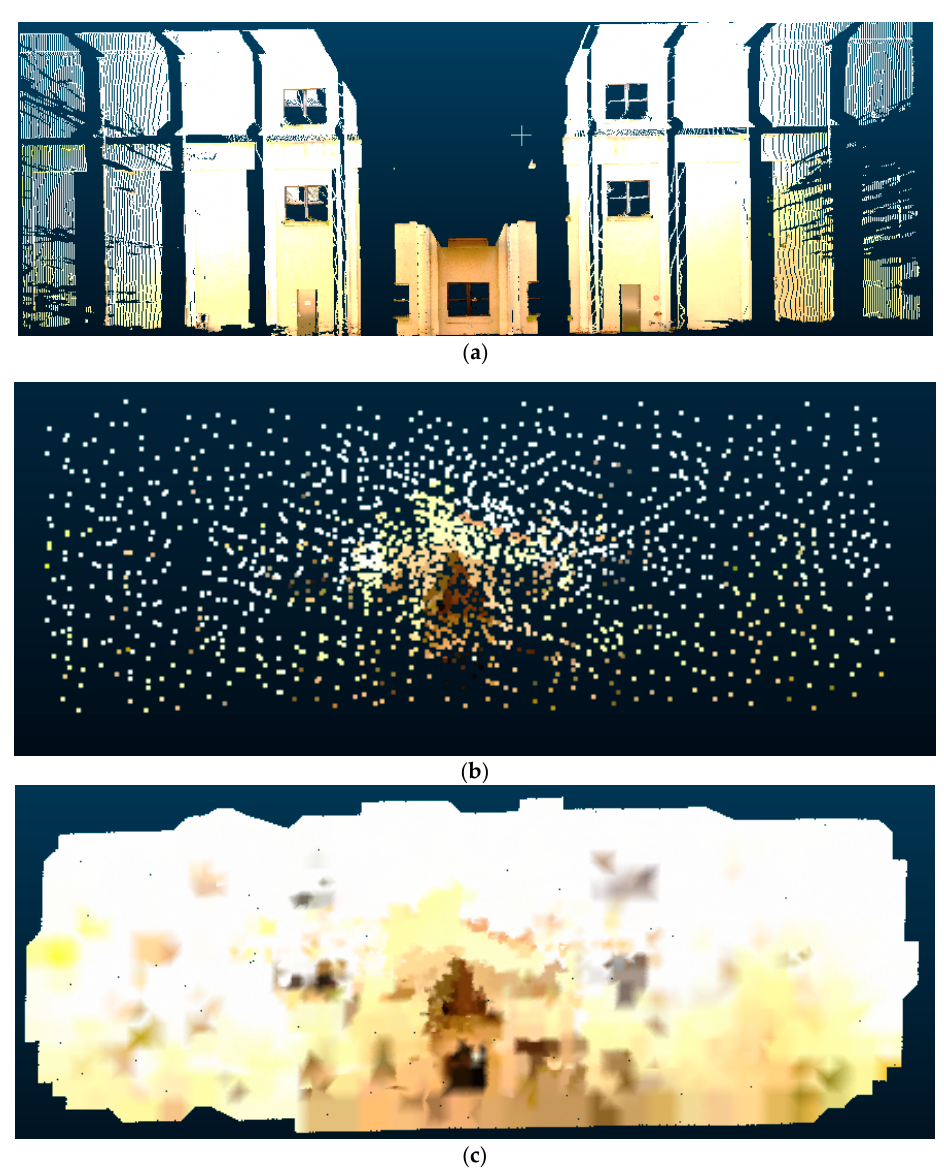
Figure 19. Point cloud scene completion results using point completion network (PCN): ( a ) input point cloud, ( b ) output point cloud, and ( c ) output point cloud after upsampling.